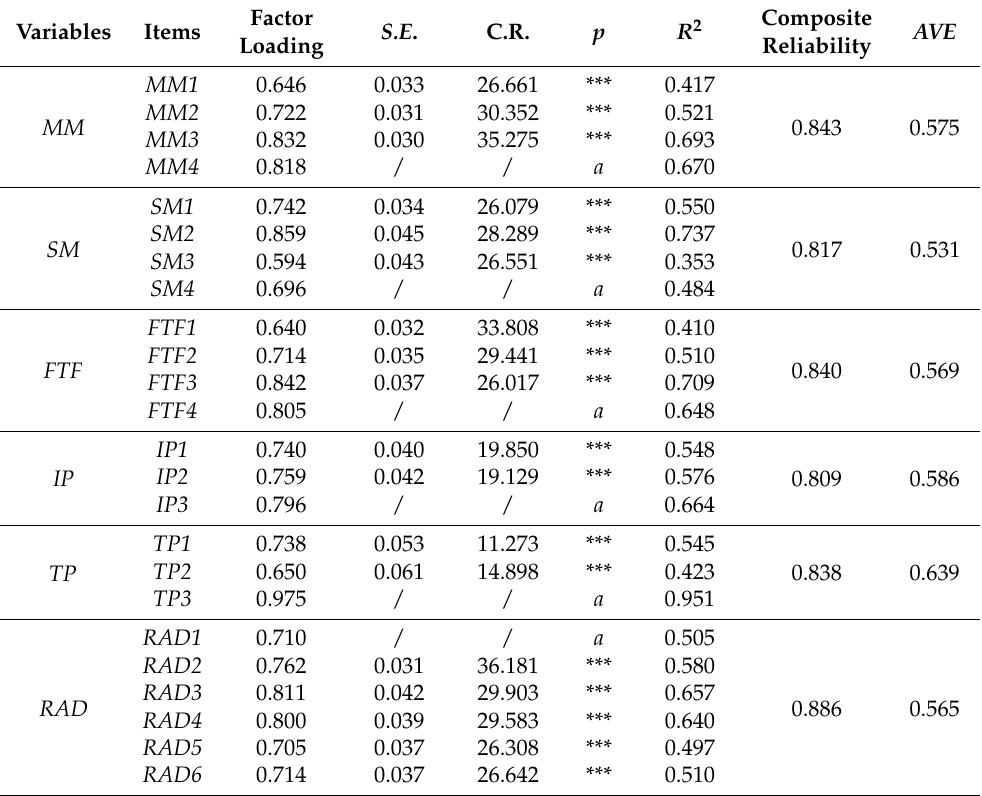
Table 4. Confirmatory Factor Analysis Results for Multi-stage